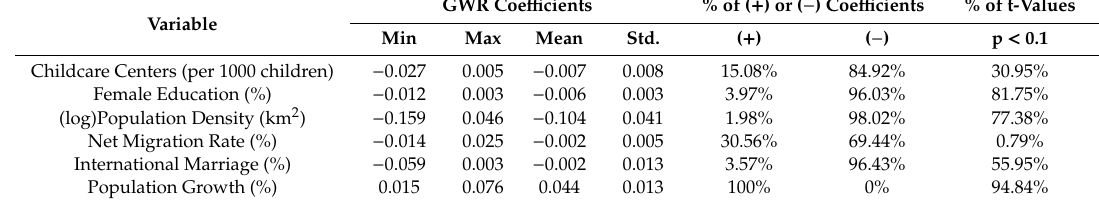
Table 3. Summary of Geographically Weighted Regression (GWR) statistics.